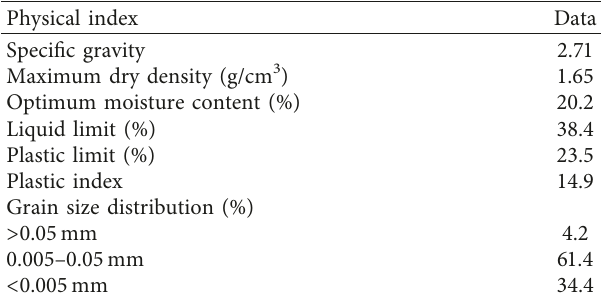
Table 1: Basic physical parameters of the soil